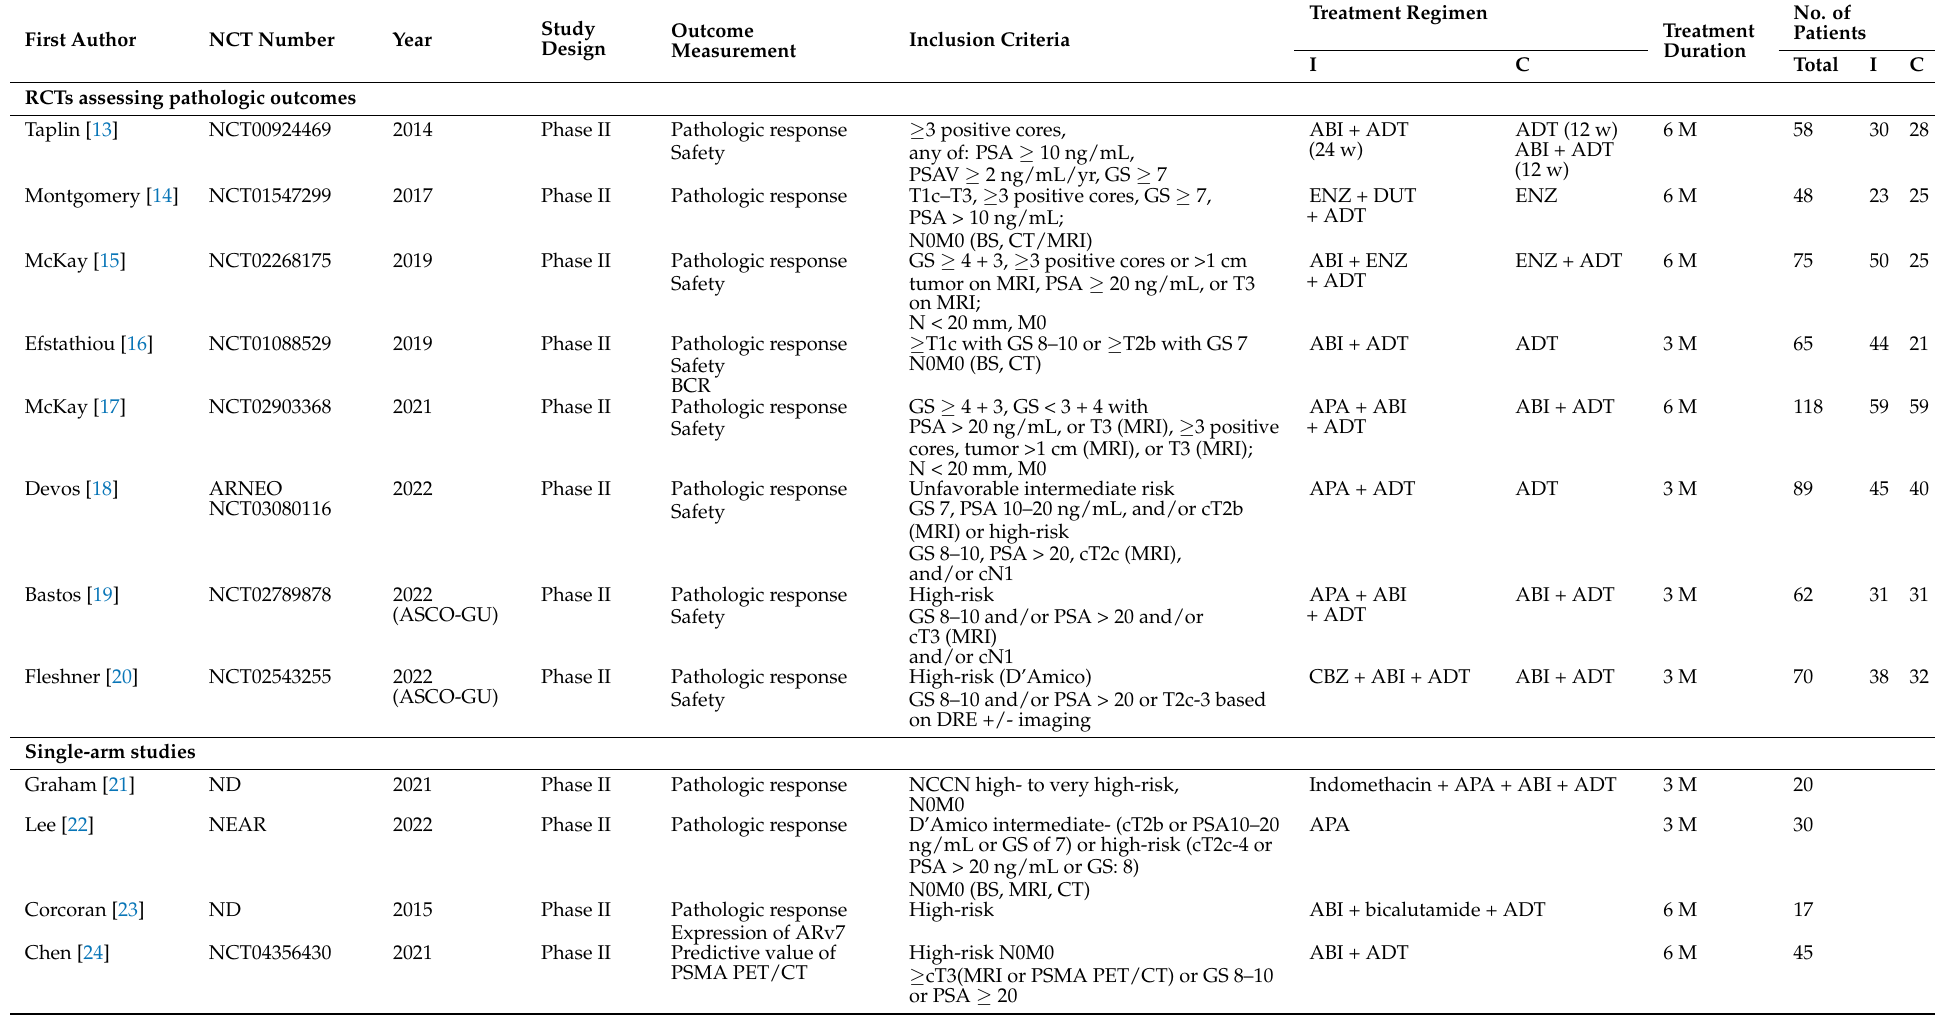
Table 1. Study and patient demographics of the 20 included